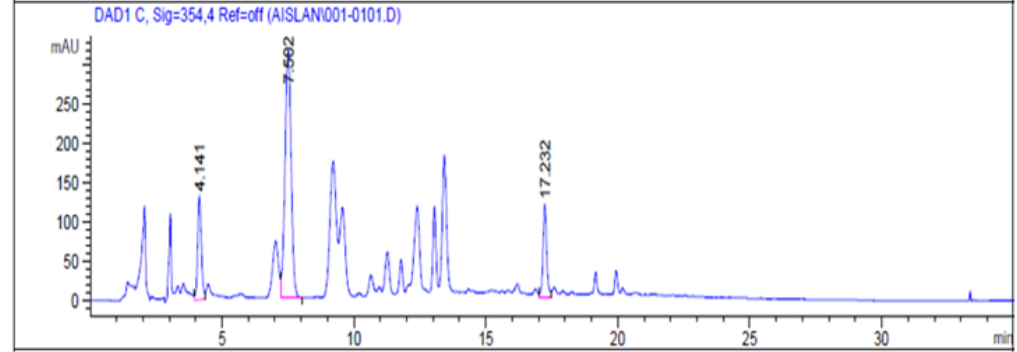
Figure 4 . HPLC-DAD chromatogram of S. microglossa extract. Temperature 30 °C; flow rate 0.8 mL/min; 20 μL injection volume; and detection at 354 nm. Gradient program of 1% acetic acid in water (solvent A) and acetonitrile (solvent B): 0-5 min (20% B), 5-15 min (20-40% B), 15-25 min (40-80% B), 25-26 min (80-100% B), 26-30 min (100% B) 30-31 min (100-20% B) and 31-35 min (20%